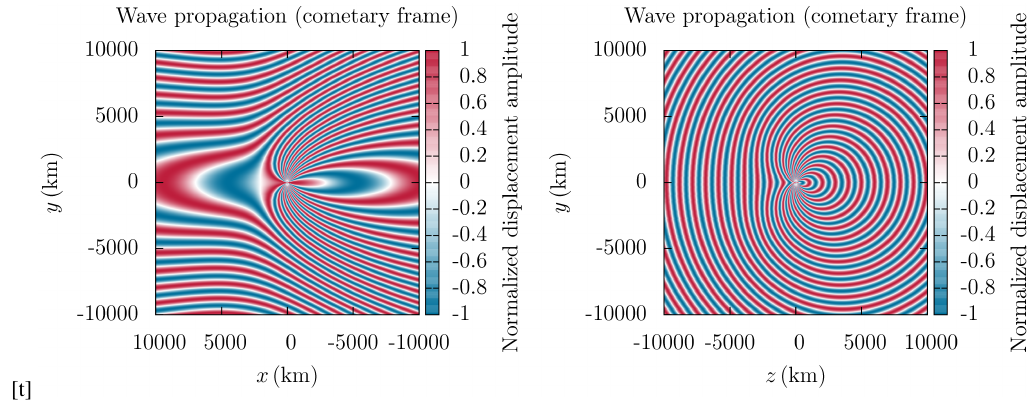
Figure 8. Wave (cid:57) (cid:48) Eq. (20) with t = 100s (in CSEQ) for the same cross sections as in Fig. 7.